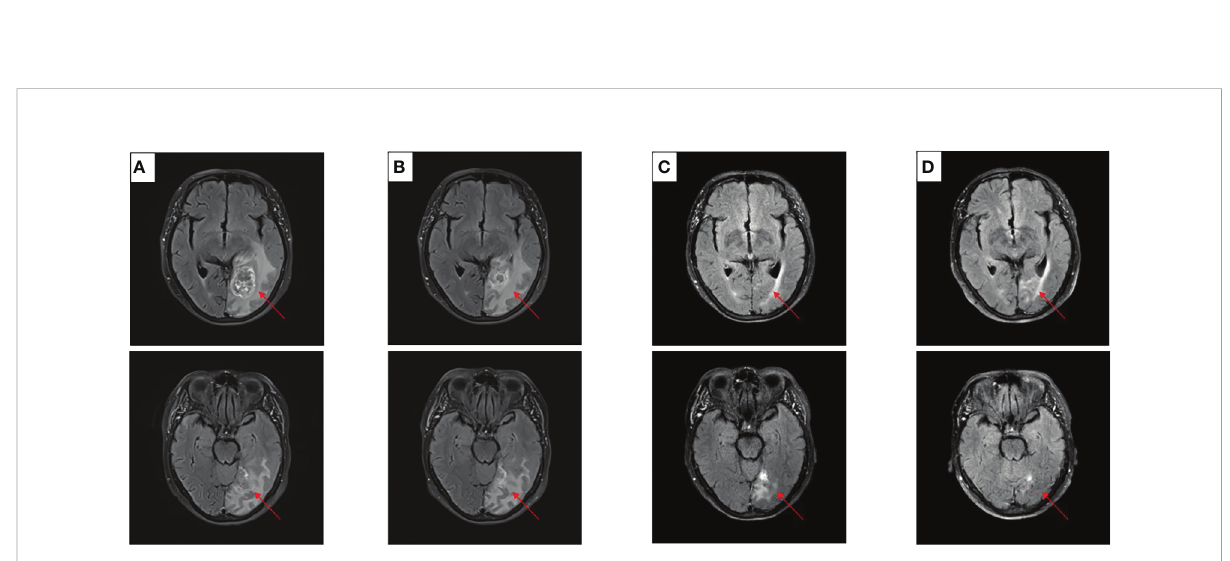
FIGURE 3 Craniocerebral MRI about clinical response to dacomitinib therapy at different times. (A) Baseline before dacomitinib treatment. (B) Brain metastases partial response (PR) after 2 months. (C) Brain metastases PR after 4 months. (D) Brain metastases PR after 6 months.